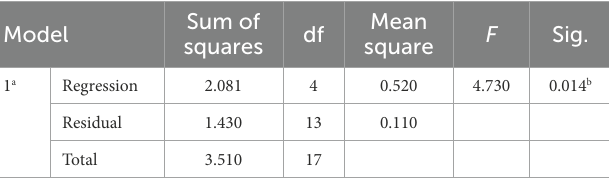
TABLE 4 Analysis of